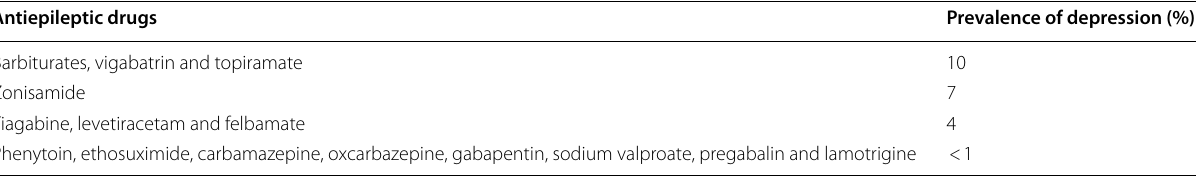
Table 5 Proportion of depression risk of antiepileptic